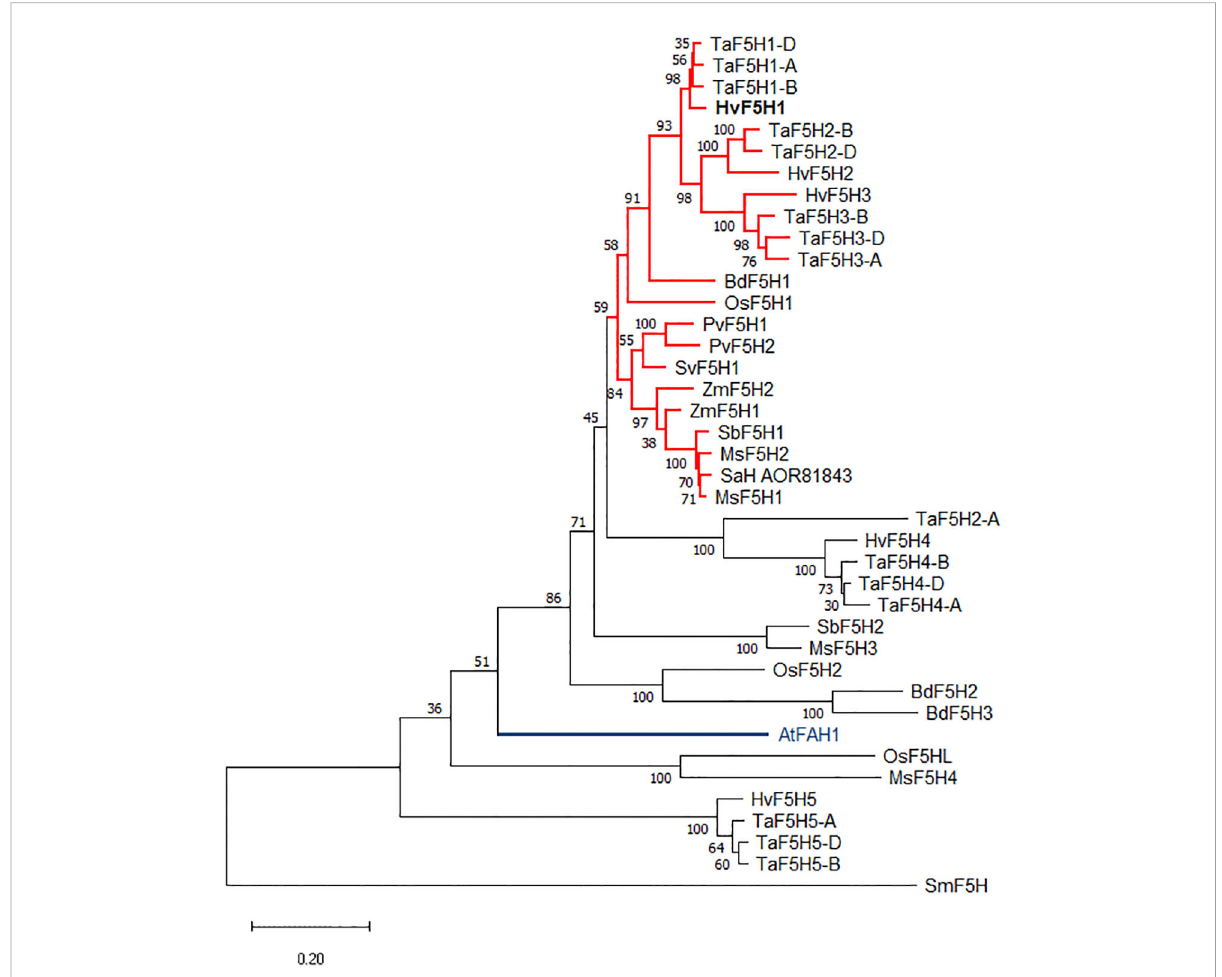
FIGURE 1 The rooted phylogenetic tree was constructed using the Maximum Likelihood method and JTT matrix-based model, with the F5H protein sequences from Selaginella moellenodorf fi i (Sm), barley (Hv), wheat (Ta), rice (Os), maize (Zm), Brachypodium (Bd), Miscanthus (Ms), sugarcane (SaH), sorghum (Sb), switchgrass (Pv), green foxtail (Sv), and Arabidopsis (At). The Arabidopsis AtFAH1 is highlighted in blue. All functionally characterised grass F5H proteins with activity in lignin biosynthesis belong to the red coloured clade although not all the proteins in this clade have been characterised. Bootstrapping values from 100 trials are shown next to the branches. The tree is drawn to scale and the scale bar represents 0.2 amino acid substitutions per site. See Table S1 for the accession numbers and further